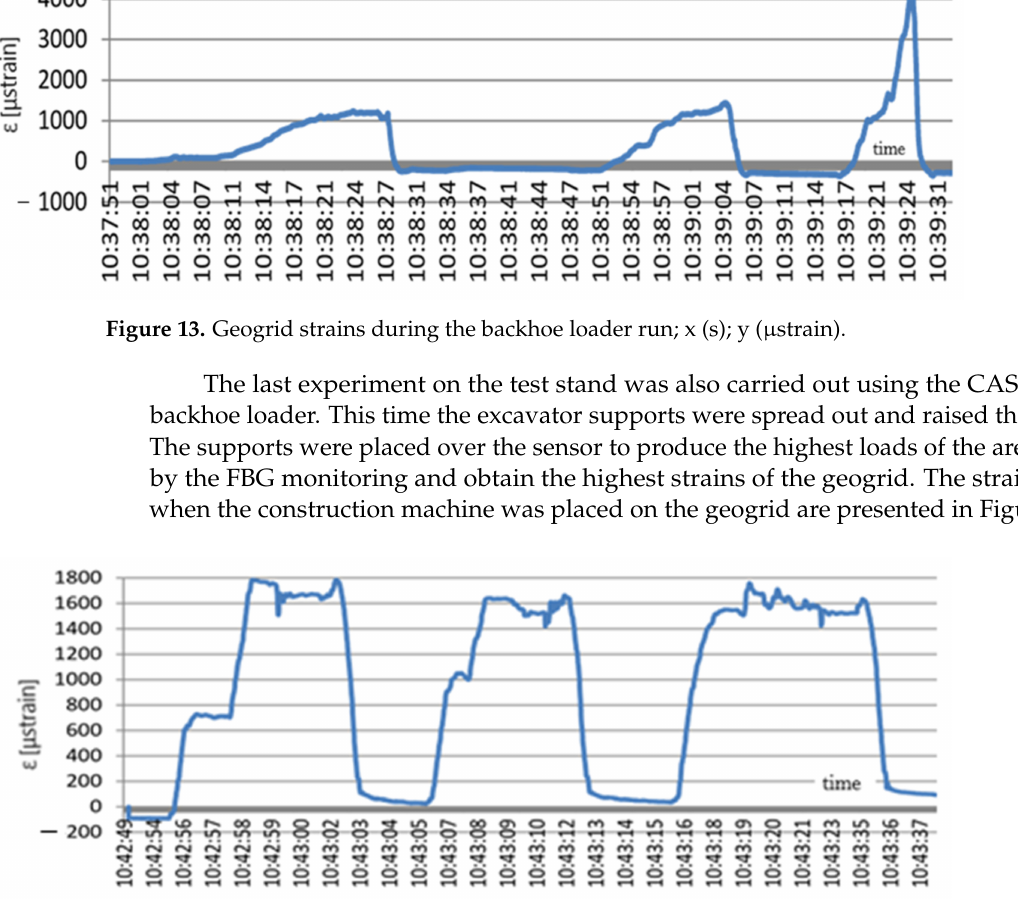
Figure 14. Change in the geogrid strain values due to the impact of the loader weight; x (s); y ( µ strain). Raising the loader on the supports caused an increase in the geogrid strain. After the first raising the strain level totalled 1780 µ strain. When the loader left the stand, the strain values decreased almost to zero to reach the level of 1650 µ strain at the next raising. After the loader left the stand, the strain level dropped again to the value of 50 µ strain. In the last test of raising the loader, the obtained strain value totalled 1770 µ strain. The drop in strain below zero from 10:43:42 h proves that the loader left the